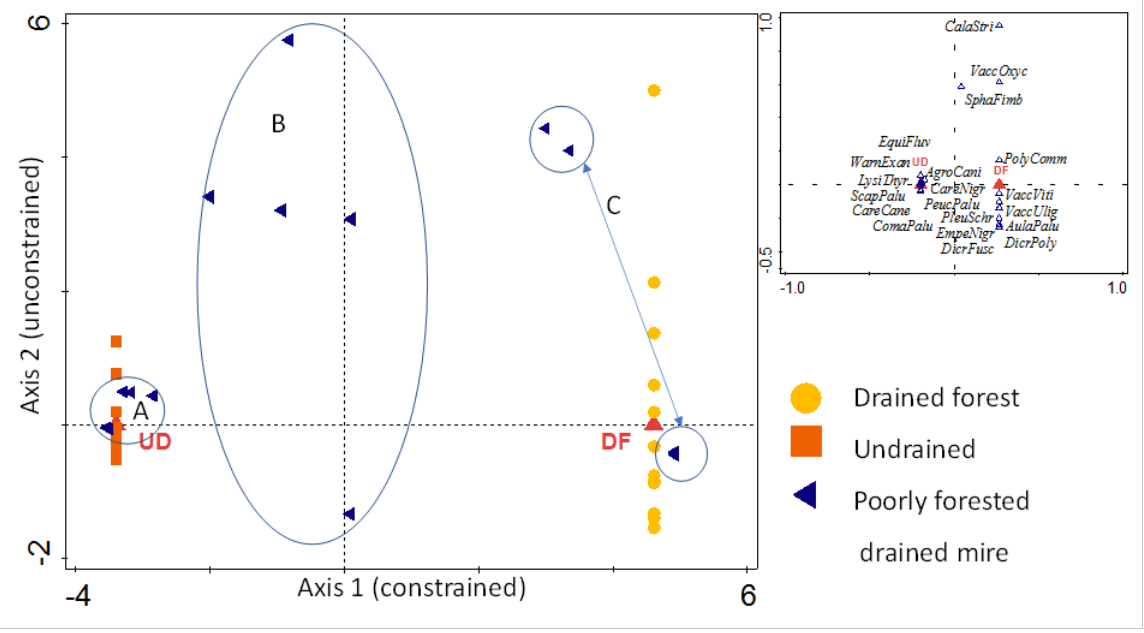
Figure 2. Vegetation ordination based on CCA analysis of Undrained and Drained forestry sites using their drainage status (0/1) as canonical explanatory variable. The sample plots from the Poorly forested drained mire are included as supplementary samples so that their positions are freely determined. Based on their sample scores along Ordination Axis 1 the Poorly forested drained mire site plots are divided into three categories A, B and C. Eigenvalues of Axis 1 and Axis 2 are 0.936 and 0.315, respectively. The small panel shows the 20 best fitting plant